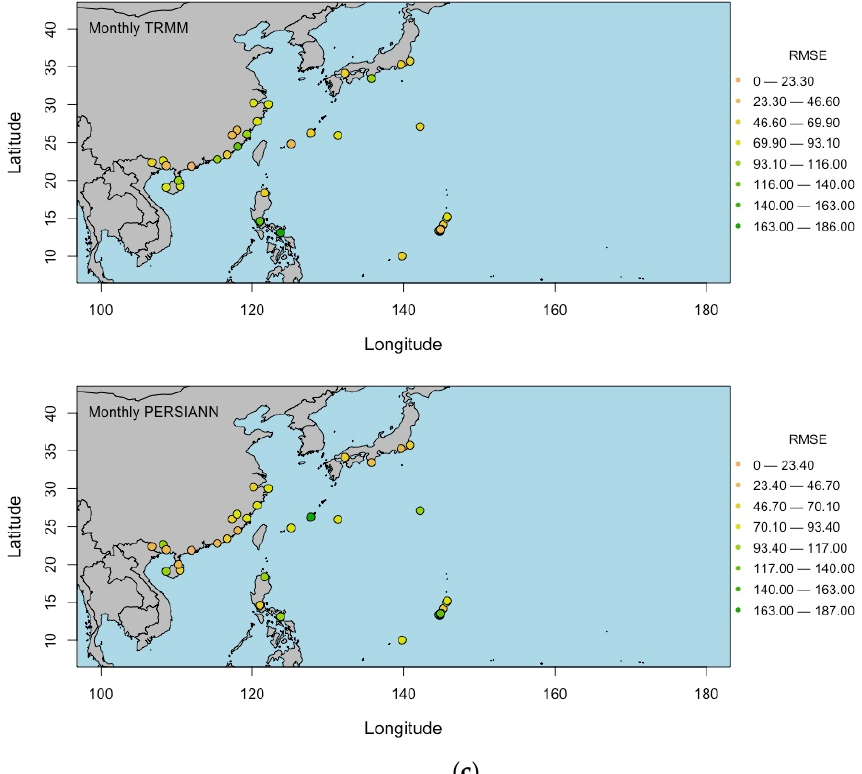
Figure 6. ( a ) Root mean square error (RMSE) values for daily rainfall for TRMM (top) and PERSIANN (bottom) for each station. ( b ) Root mean square error (RMSE) values for weekly rainfall for TRMM (top) and PERSIANN (bottom) for each station. ( c ) Root mean square error (RMSE) values for monthly rainfall for TRMM (top) and PERSIANN (bottom) for each station.